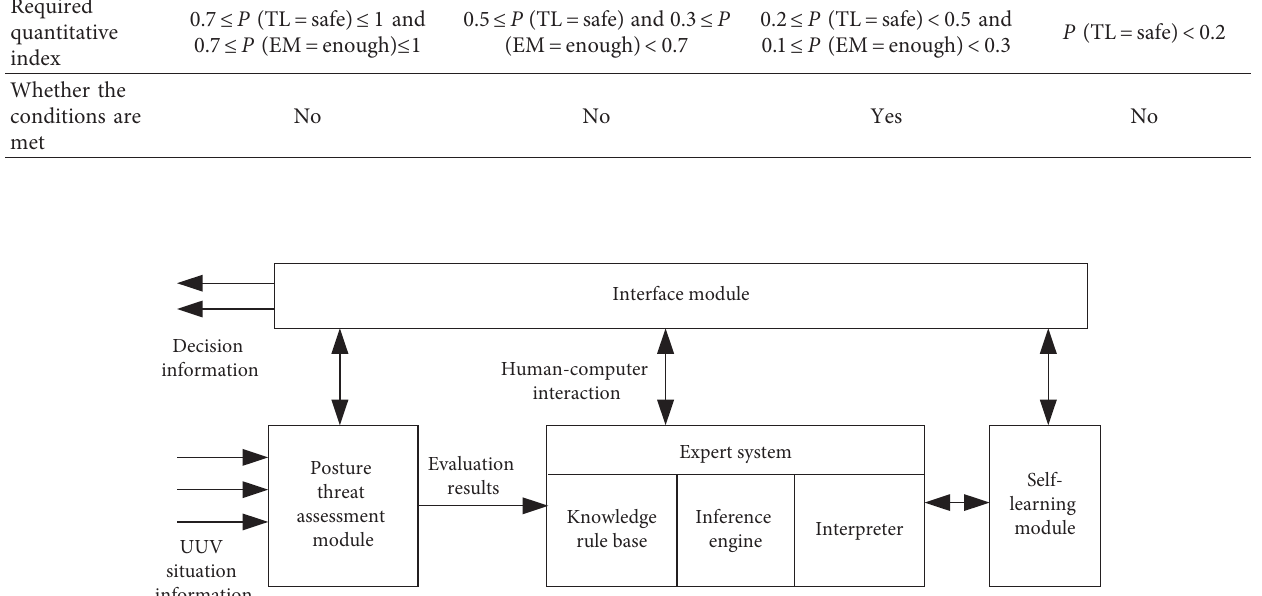
Figure 8: Block diagram of the UUV expert-based autonomous decision system.